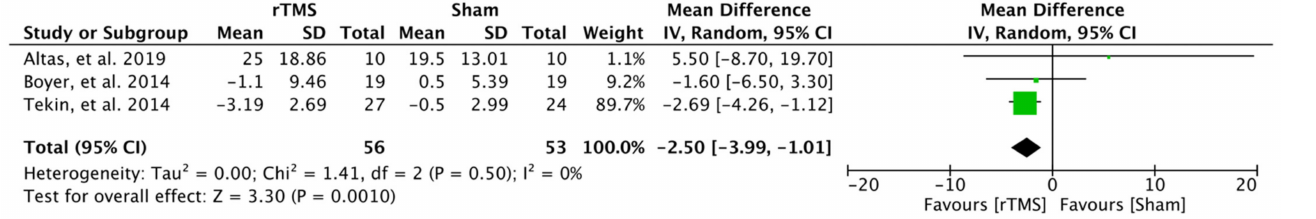
Figure 4. Forest plot on the effect of repetitive transcranial magnetic stimulation on quality of life.